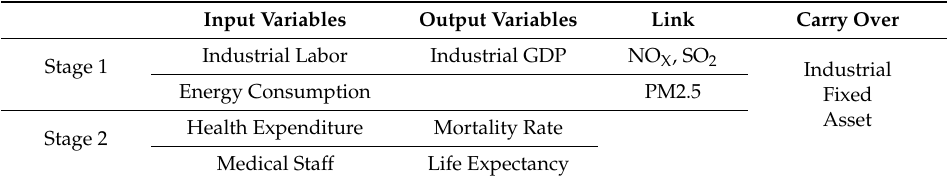
Table 1. Input and output